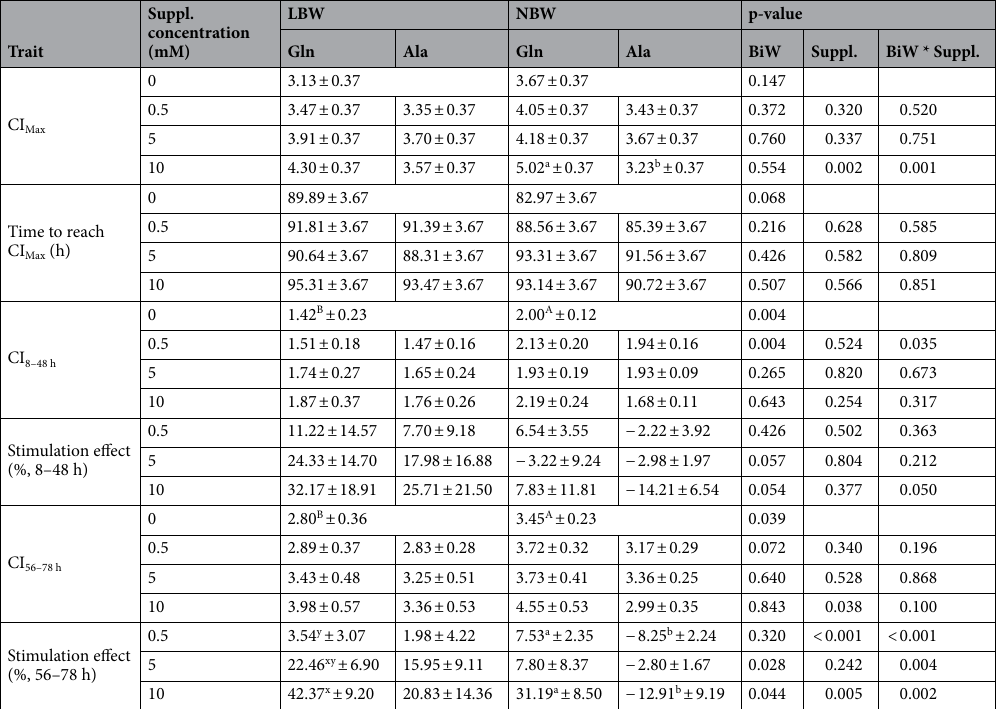
Table 1. Growth parameters of myogenic cells from low (LBW) or normal birth weight (NBW) piglets cultivated in medium supplemented with different concentrations of glutamine (Gln) or alanine (Ala). Values are calculated from CI recorded with the xCELLigence RTCA-DP device and are presented as LSMeans ± SE (n = 3 assays per group). Different uppercase letters (A, B) indicate significant differences between LBW and NBW cells; lowercase letters (a, b) indicate significant differences between supplementation groups within the same cell type; different lowercase letters (x, y) indicate significant differences among supplementation concentrations within the same group ( p ≤ 0.05, Tukey–Kramer test). CI Max maximum cell index, CI 8–48 h mean cell index between 8 and 48 h, CI 56–78 h mean cell index between 56 and 78 h, Suppl.